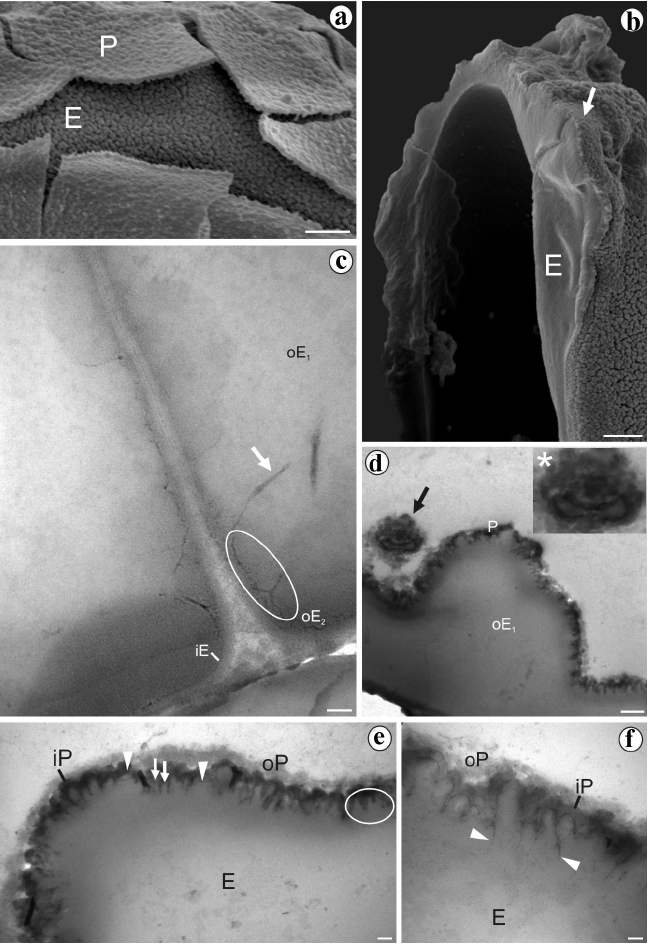
Figure 6 - Spores of Histiopteris incisa with SEM and TEM. Tuberculate- reticulate